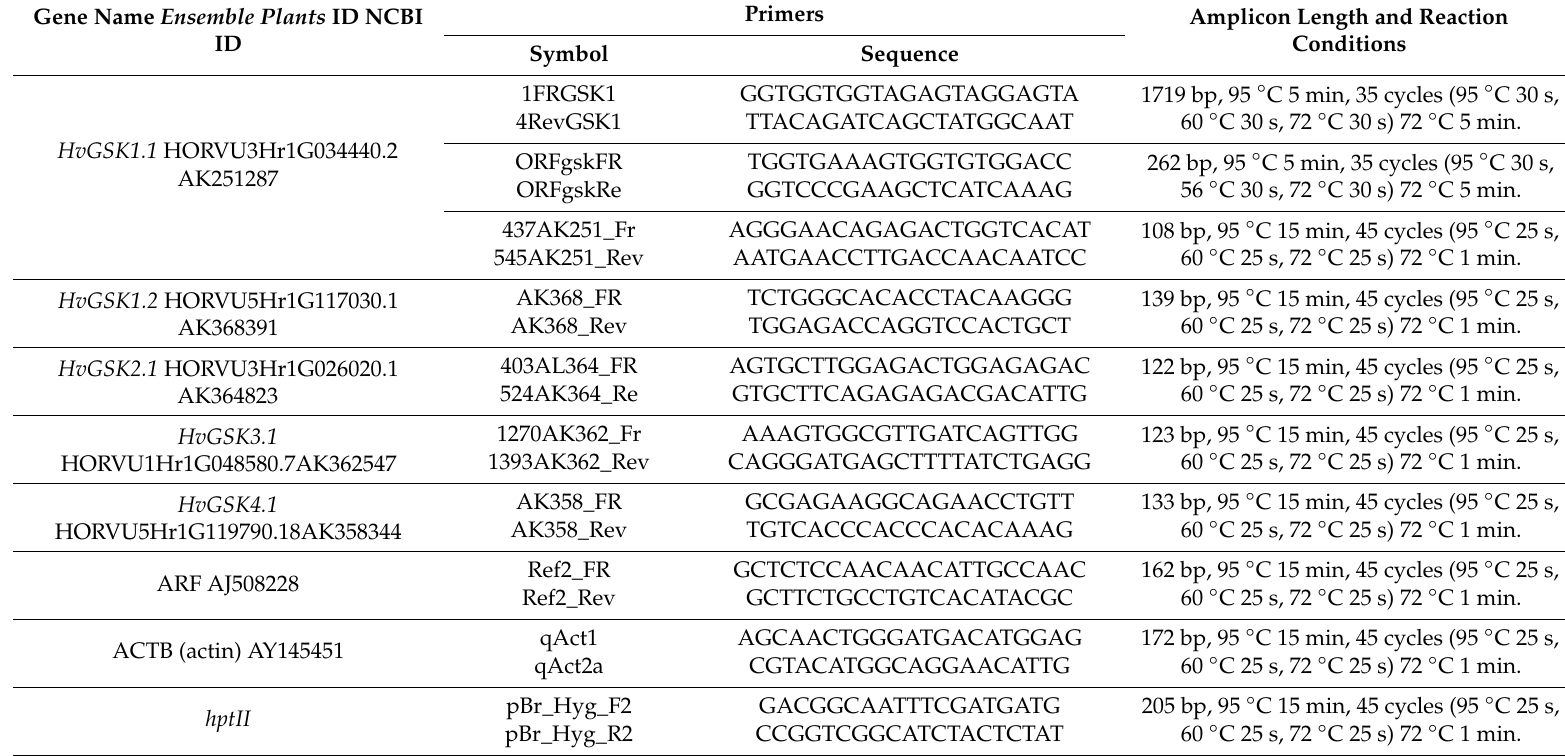
Table 2. List of primers and reaction conditions used in this